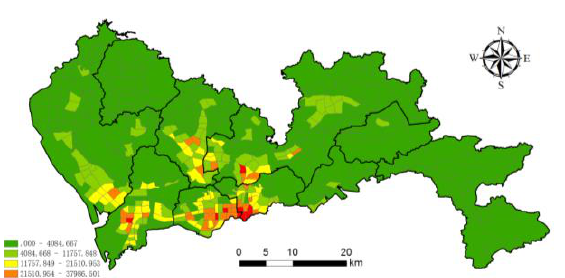
Figure 6. Spatial distribution of travel spatial density inferred from smart card data